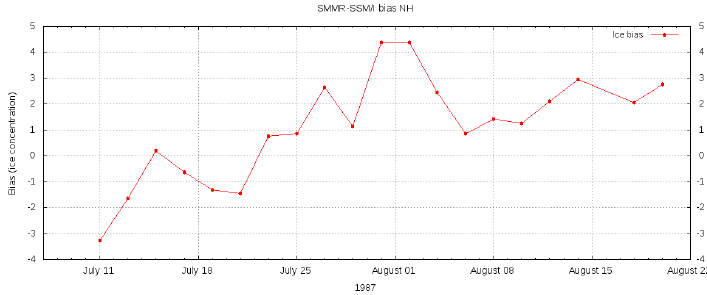
Figure 8. The overlapping SMMR–SSM/I difference in the Arctic during summer melt. The red curve shows the ice bias.